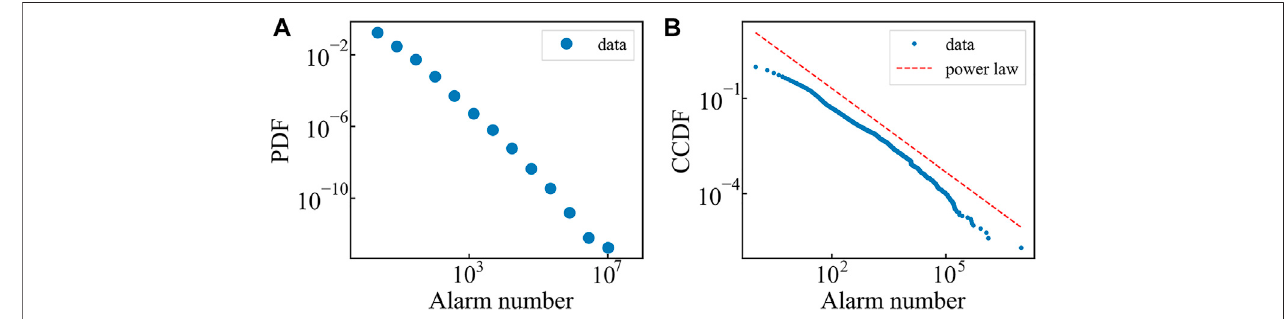
FIGURE 2 | (A) Probability density function (pdf) of alarm times with log-log coordinate. (B) Complementary cumulative distribution function (ccdf) of alarm times with log-log coordinate. The data follows a straight line in log-log coordinates, which indicates that the alarm number obeys the power law distribution.